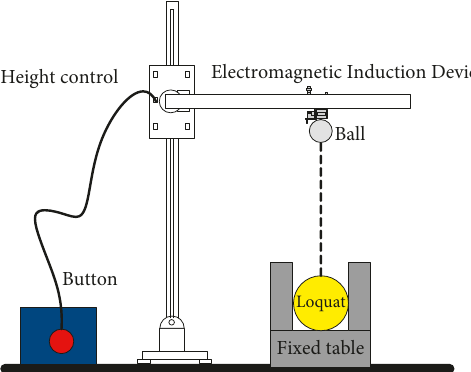
Figure 1: Free-fall collision